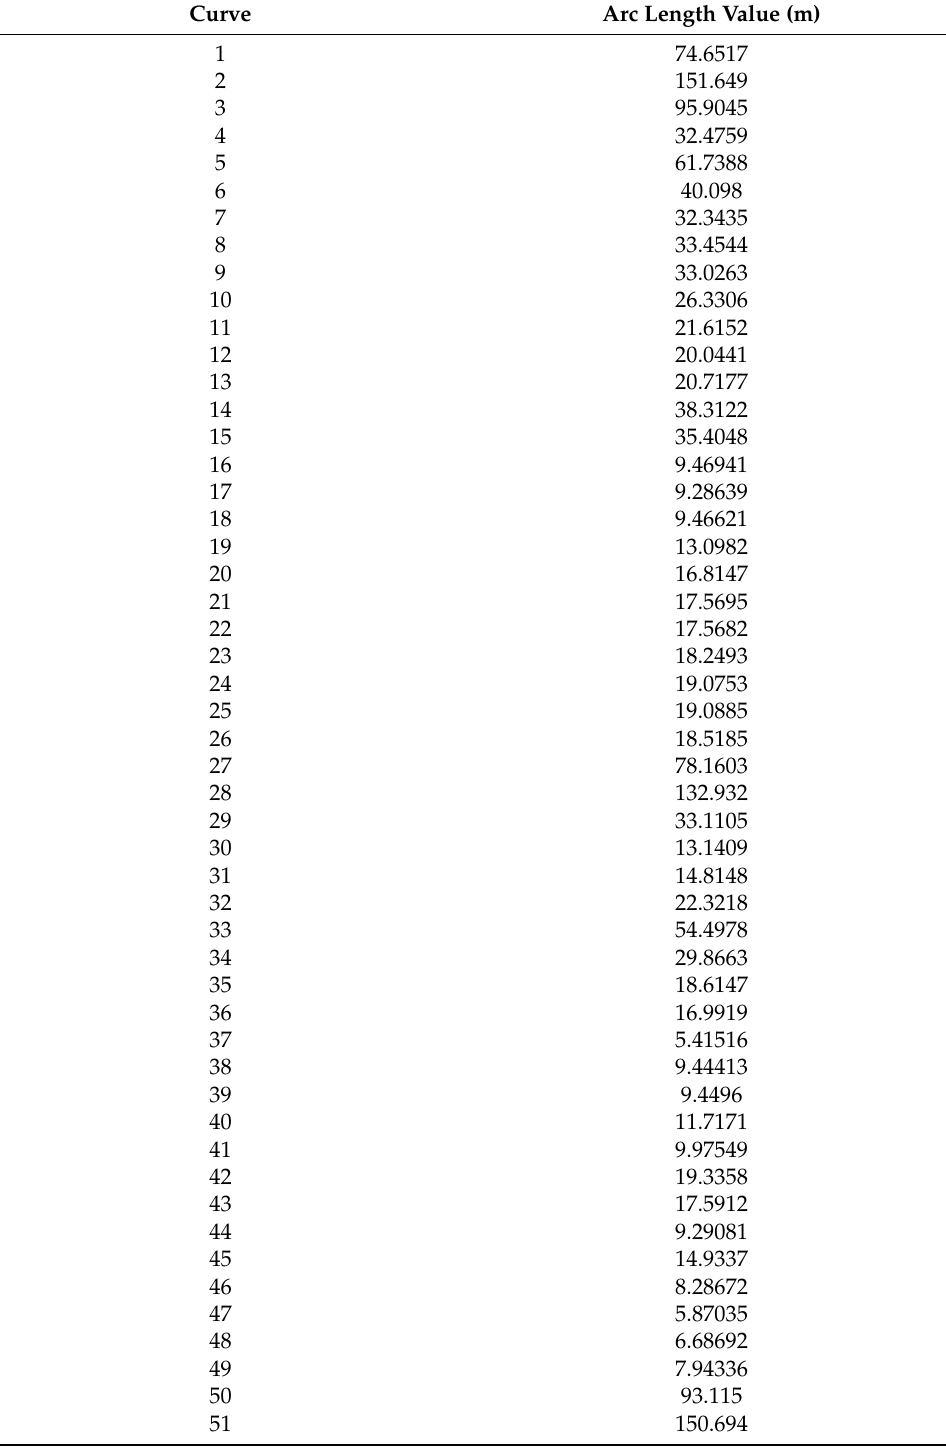
Table A2. Arc Length